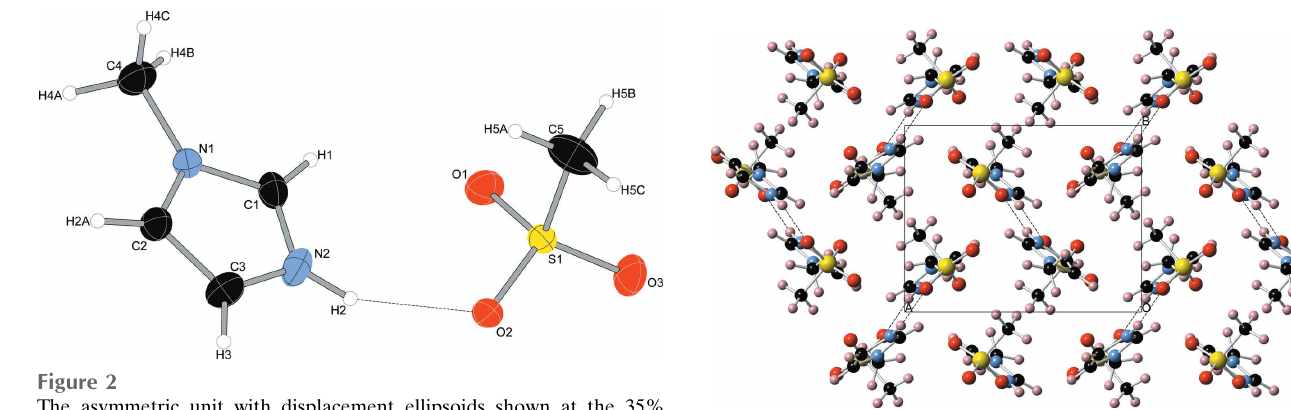
Figure 3 A view of the crystal packing of the title compound.